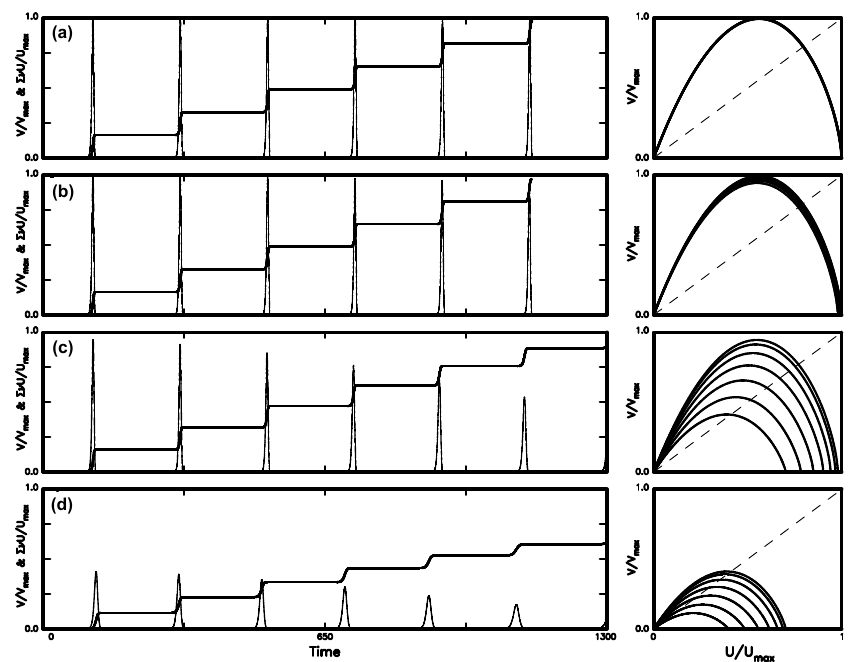
Figure 12. The time variations in V/V max (thin solid line) and cumulative slip (cid:54)U/U max (solid line) and the phase portrait of V/V max versus U/U max (solid line) for four values of C : (a) for C = 0.0001; (b) for C = 0.0010; (c) for C = 0.0100; and (d) for C = 0.0136 when U co = 0.5 and η =